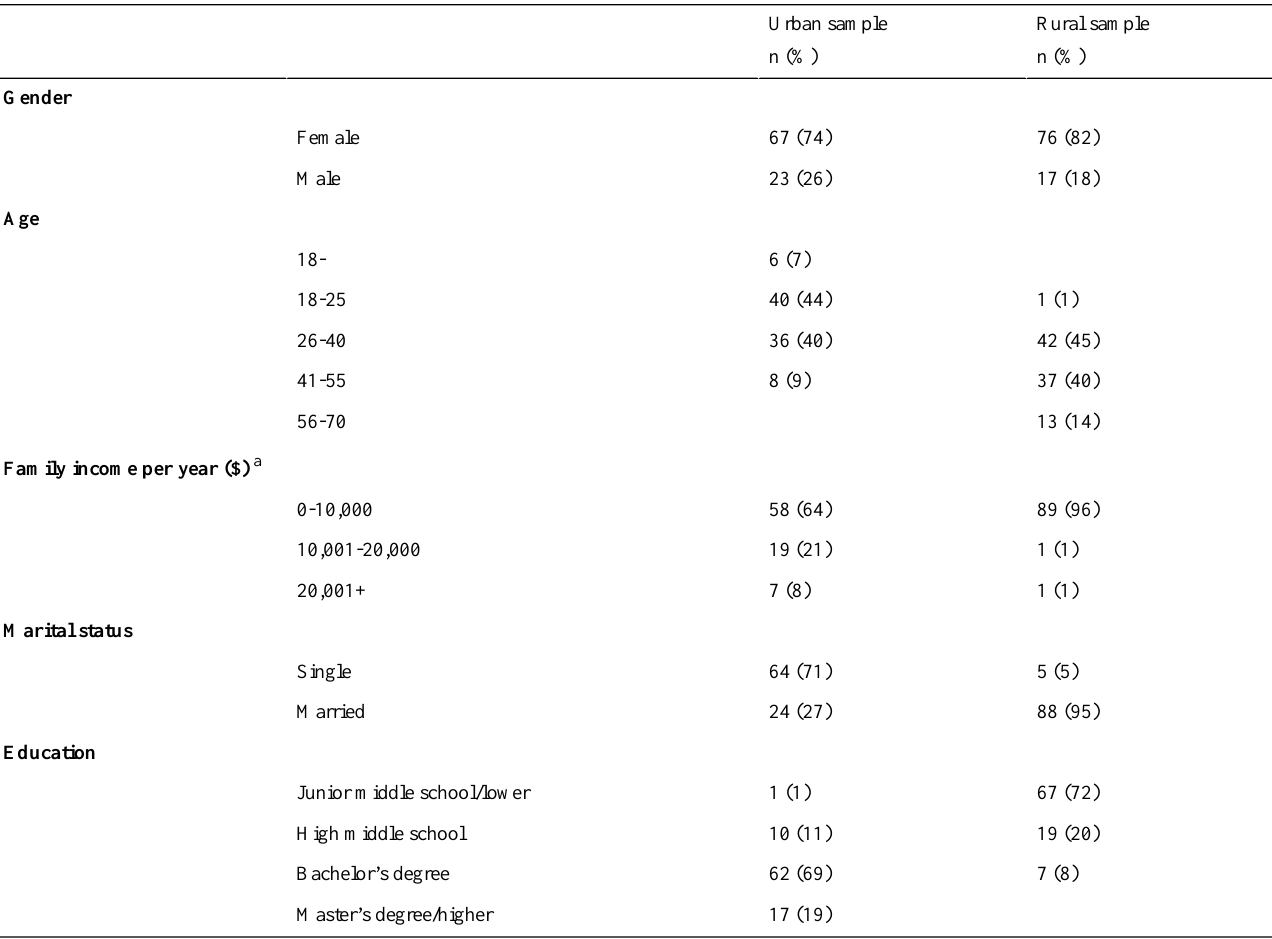
Table 1. Demographic characteristics for the urban sample (n=90) and the rural sample